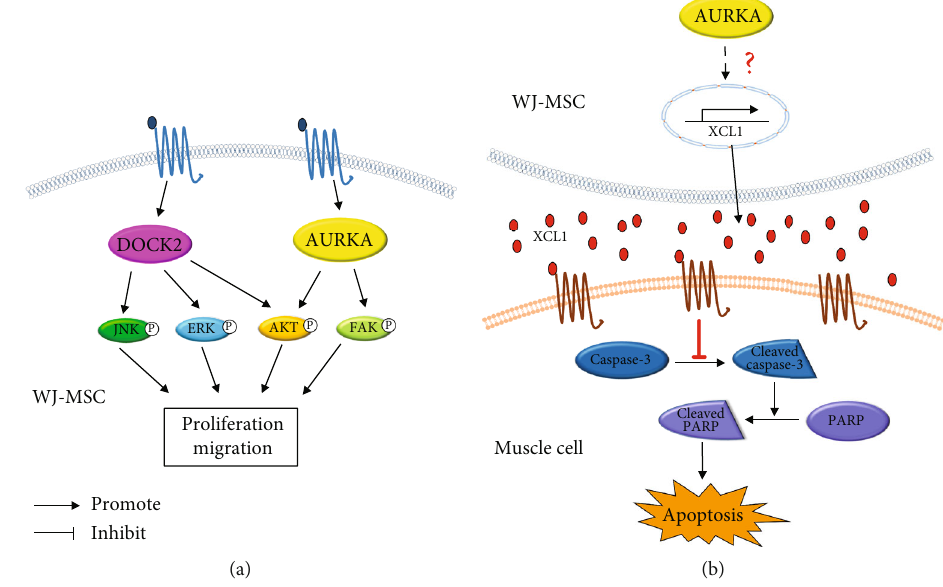
Figure 7: Both AURKA and DOCK2 contributed to cell proliferation and migration of WJ-MSCs, and AURKA of WJ-MSCs inhibited apoptosis in mdx mouse through XCL1. (a) In WJ-MSCS, both AURKA and DOCK2 promoted the proliferation and migration of WJ- MSCs through phosphorylation of kinases. (b) In WJ-MSCs, AURKA stimulated XCL1 transcription, causing XCL1 secretion from WJ- MSCs. The secreted XCL1 bound to the chemokine receptors of muscle cells, thereby inhibiting the cleavage of caspase-3 and PARP and suppressing the apoptosis of muscle